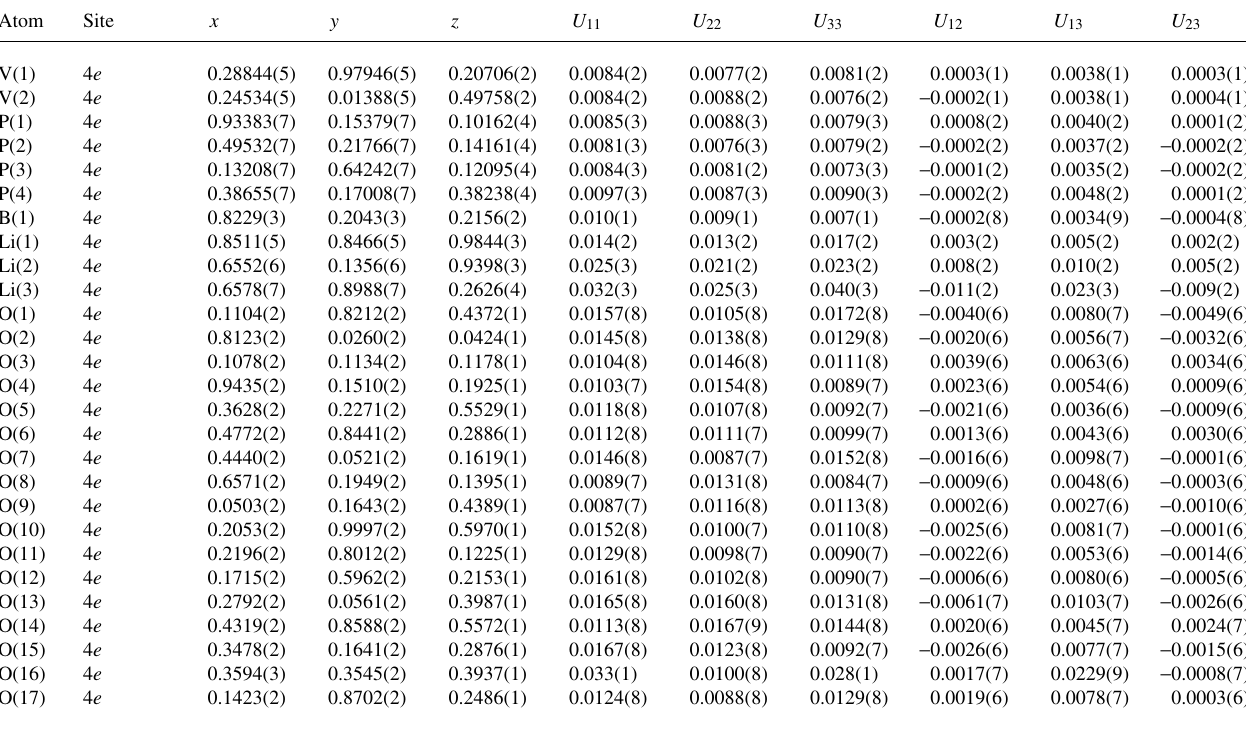
Table 3. Atomic coordinates and displacement parameters (in Å 2 ) .